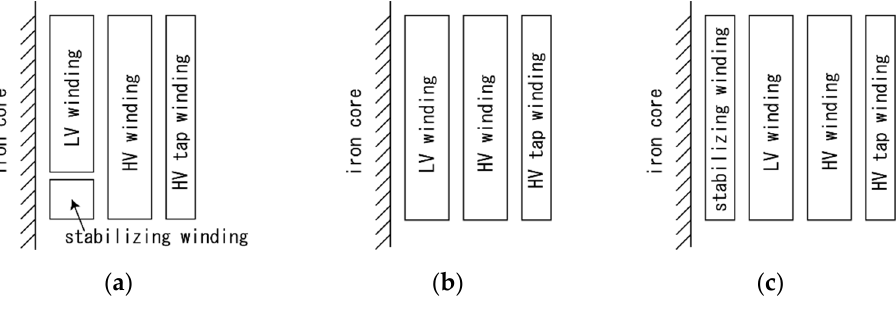
Figure 5. Winding arrangements of tested transformers. Table 1. Specifications of measured new transformers before shipping in the factory and types of RBS in TFs in IIW